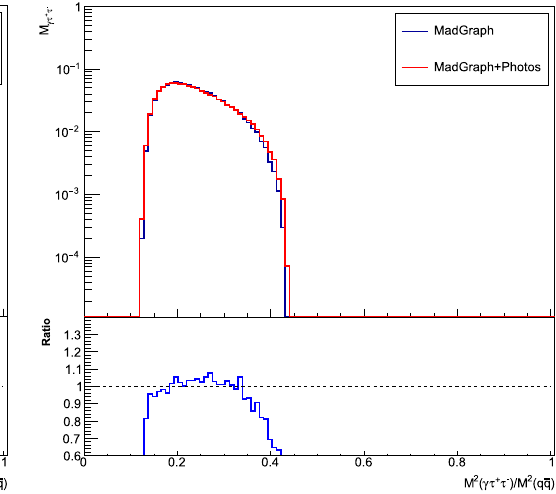
Fig. 7 The distributions of invariant mass of τ + τ − (left panel) and τ + τ − γ (right panel) for the q ¯ q → τ + τ − τ + τ − γ process at GeV with E γ > 0 . 2 GeV. The upper panel shows the absolute